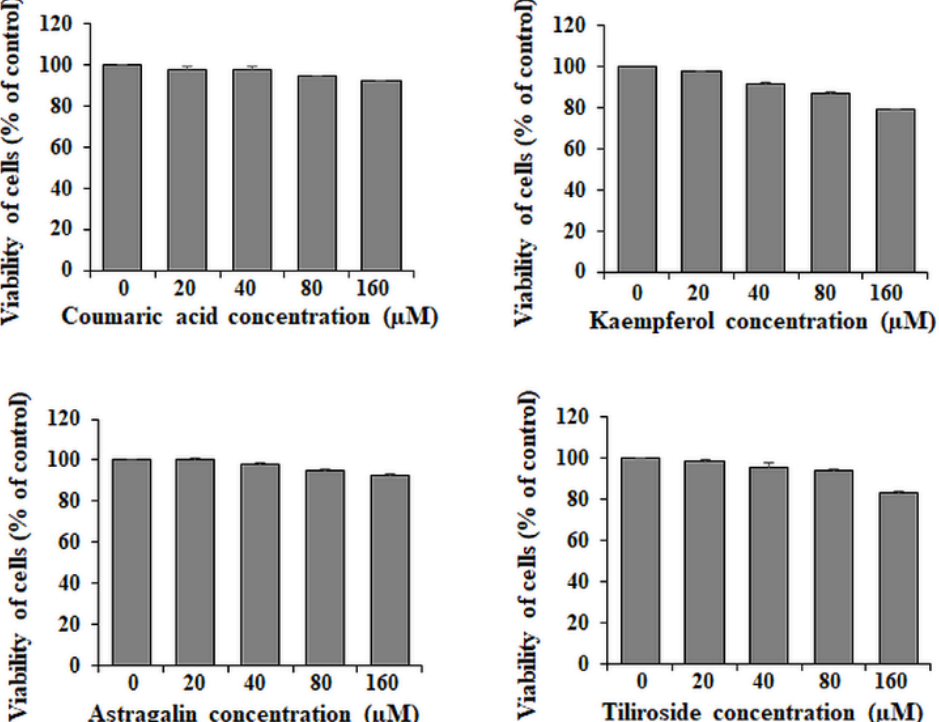
Figure 2. Viability of AGS gastric cancer cells treated for 24 h with 20–160 µM concentrations of coumaric acid, kaempferol, astragalin and tiliroside. Mean values ± SD are the mean of triplicate culture.